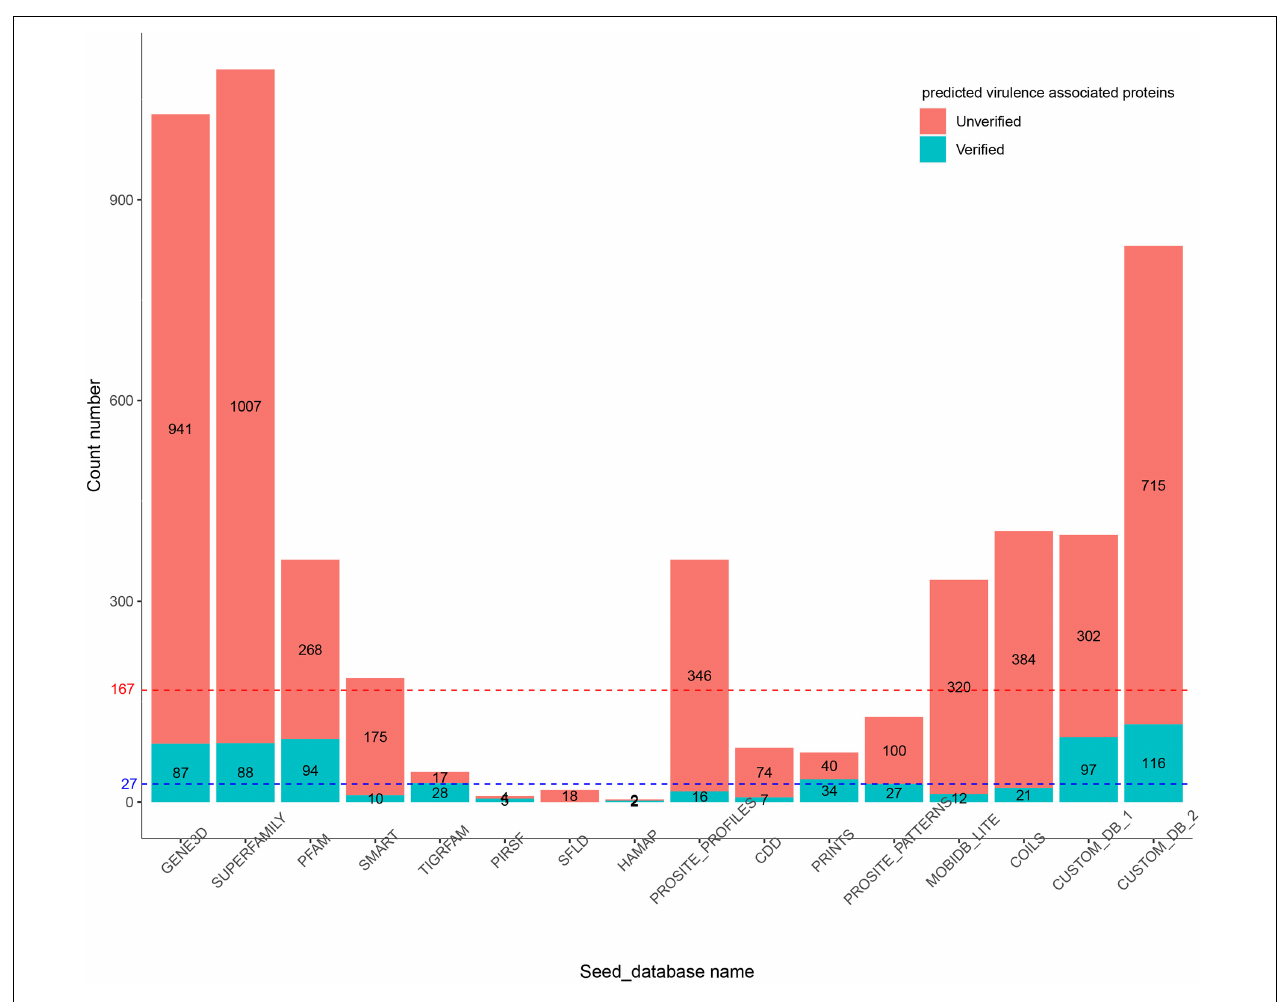
FIGURE 2 | Number of predicted virulence associated proteins in S. Typhimurium by Duo based on different Seed_databases. The blue dotted line indicates the medium number of predicted protein. The red dotted line indicates the total number of experimentally verified virulence associated proteins in S . Typhimurium